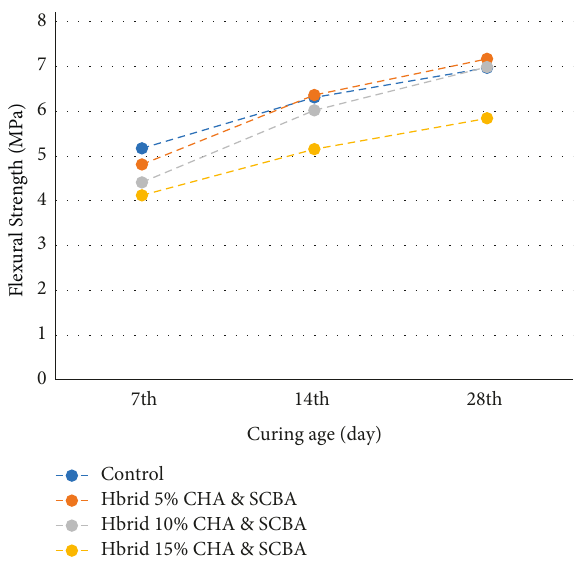
Figure 11: Flexural strength of test